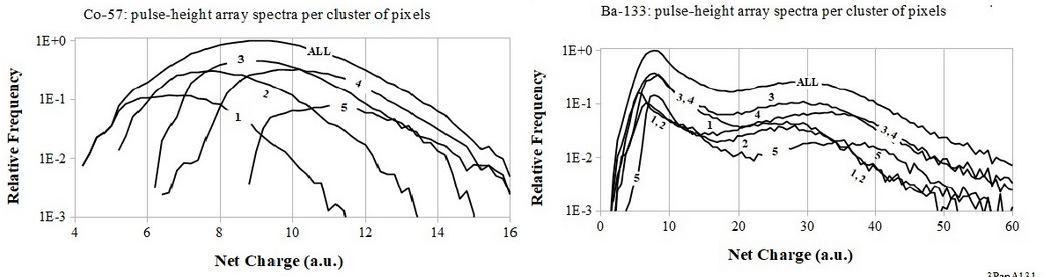
Figure 1. Semilog plots of the pulse-height spectra per cluster of pixels from Co-57 ( left ) and Ba-133 ( right ) data. The total spectra of the array are drawn (topmost curves) together with the ones of the clusters from 1 to 5. 10 -3